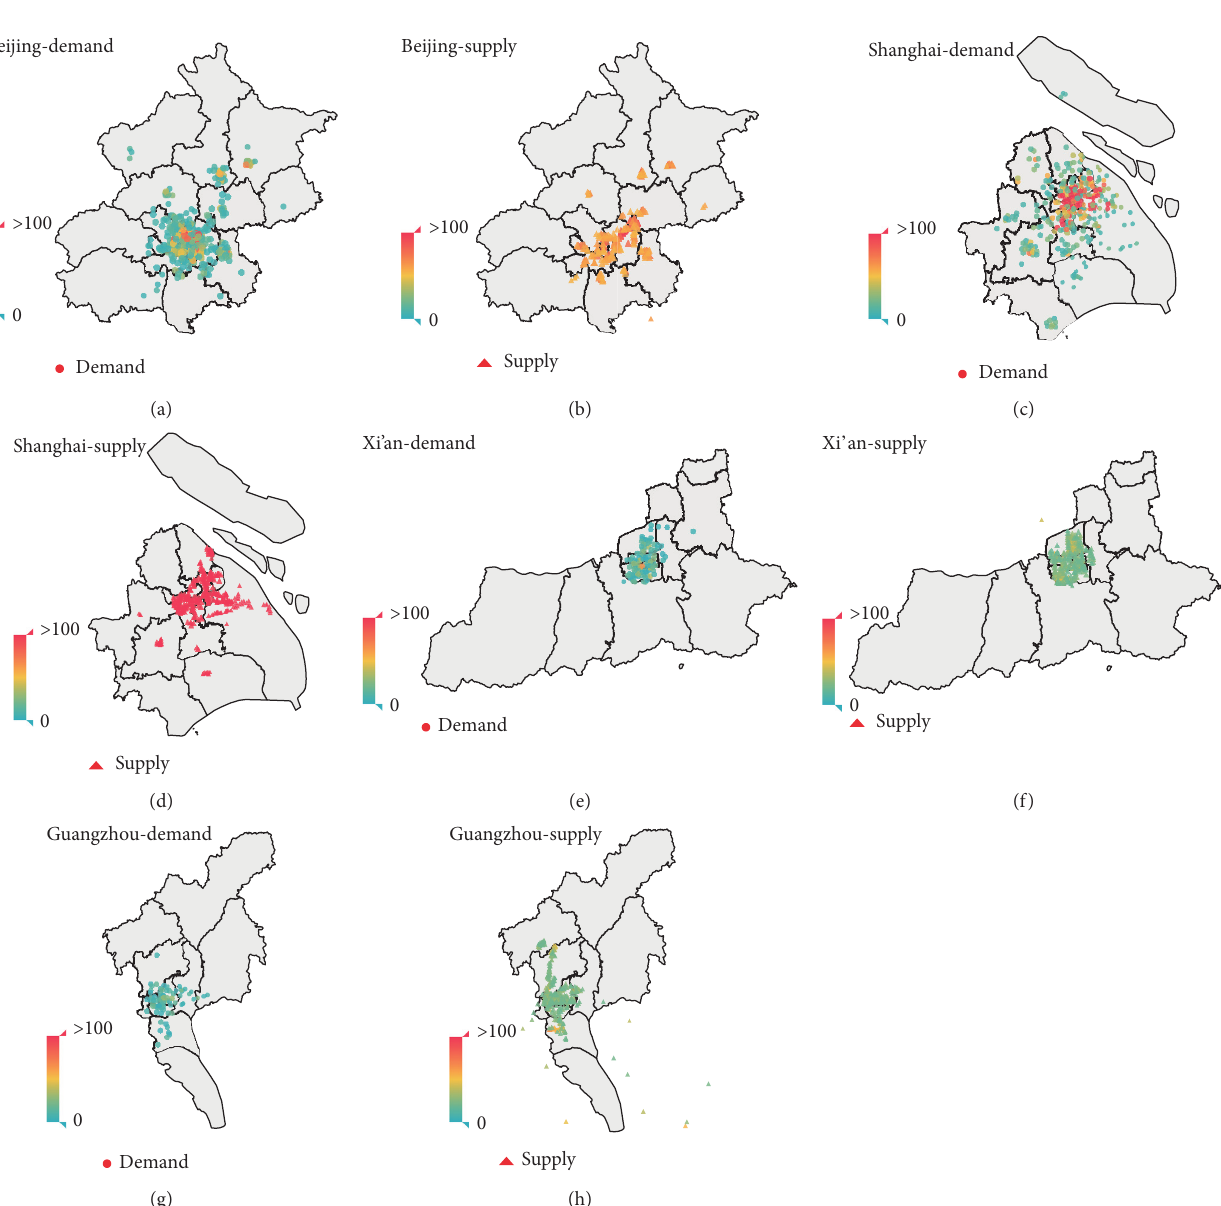
Figure 3: The supply and demand distribution of taxis at 8